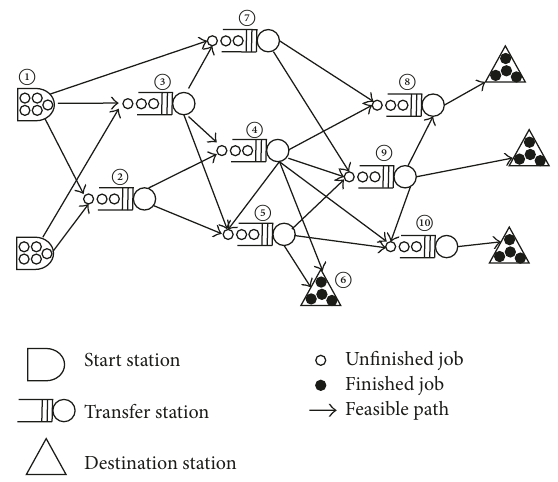
Figure 1: An example of self-organizing network with multitype